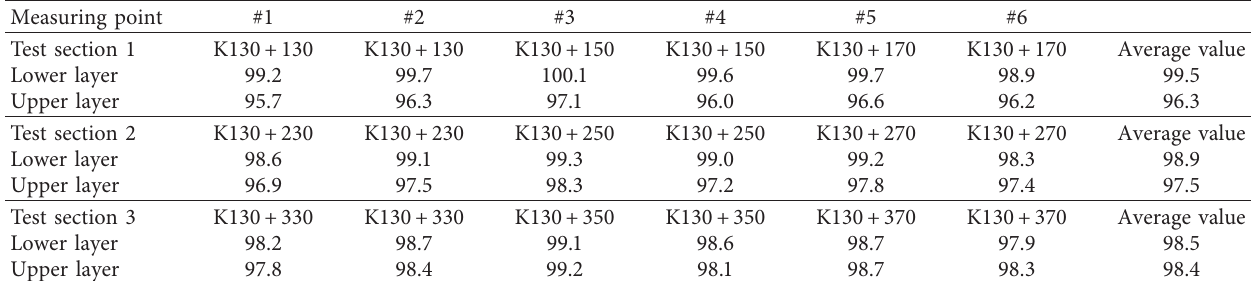
Table 9: Field test results of compaction degree in test section 1.